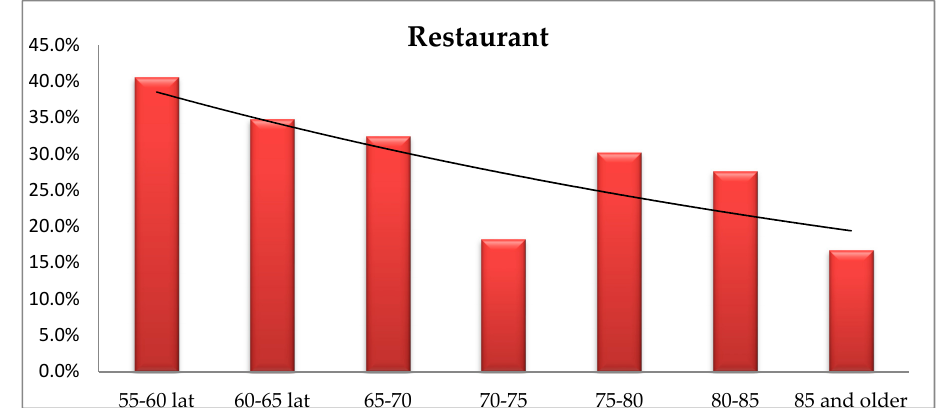
Figure 13. The respondents’ age vs. the opinion on the need of a restaurant in their immediate environment.